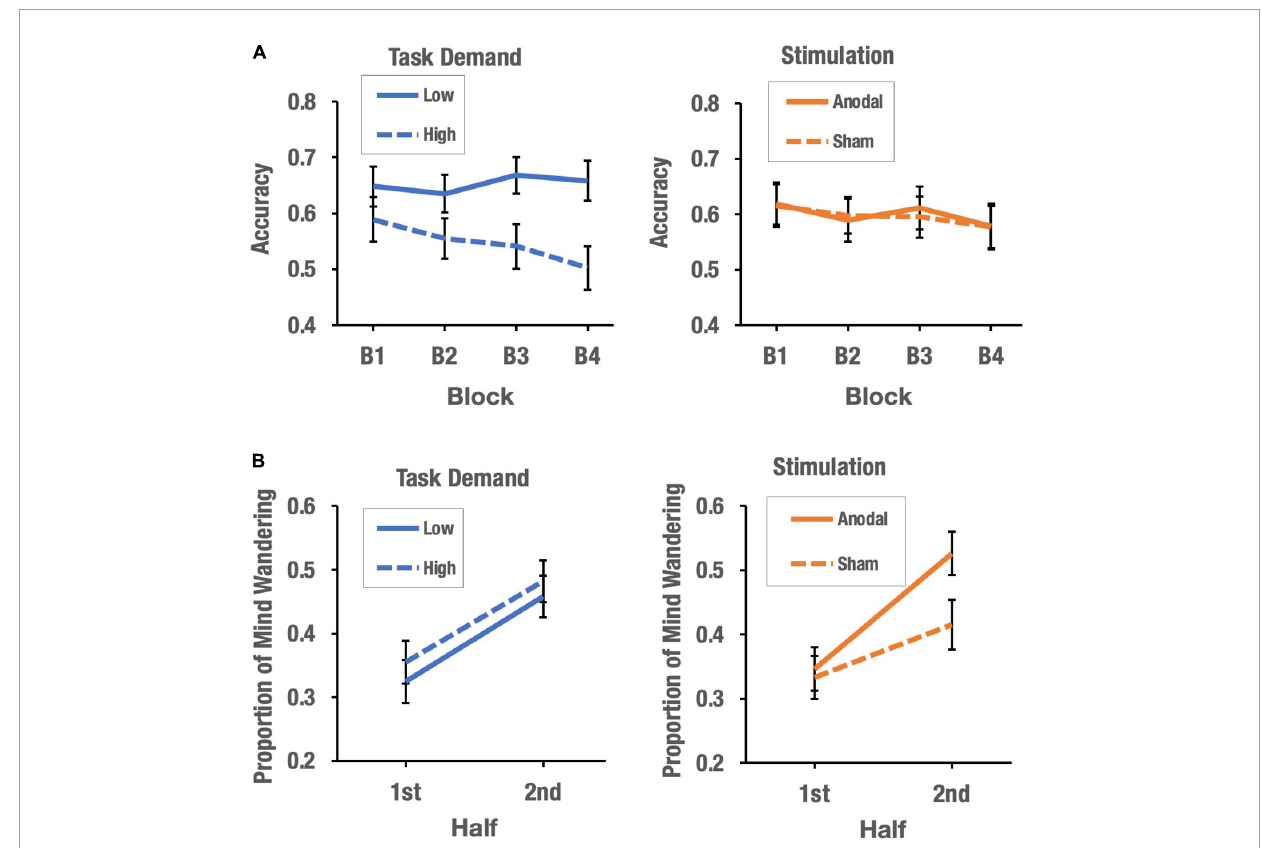
FIGURE3 The effects of task demand and stimulation on vigilance decrement (A) and mind-wandering (B)